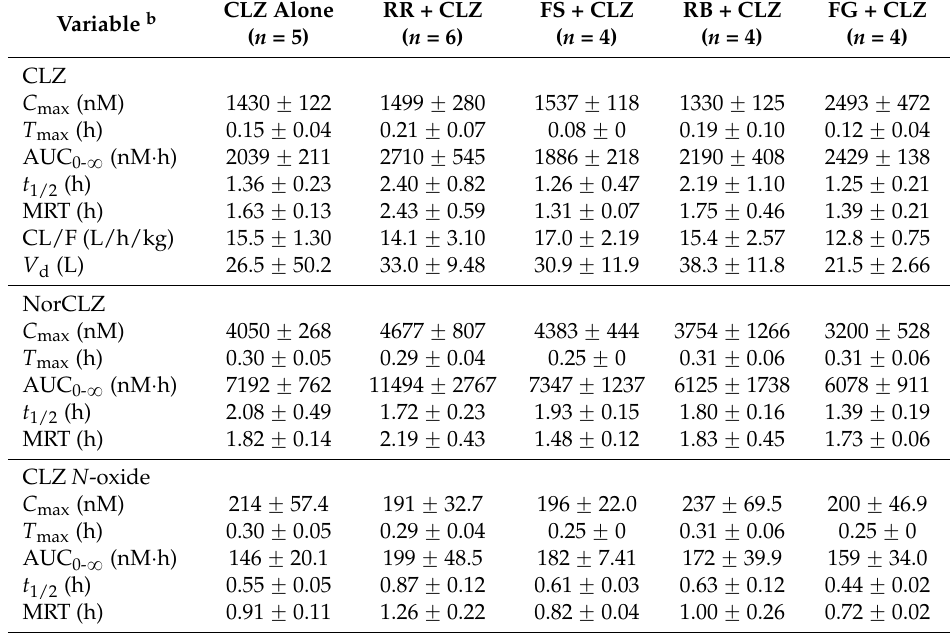
Table 2. Effects of chronic co-treatment with Radix Rehmanniae (RR), Fructus Schisandrae (FS), Radix Bupleuri (RB), and Fructus Gardeniae (FG) on the pharmacokinetics of plasma clozapine, norclozapine (norCLZ), and clozapine N -oxide (CLZ N -oxide) in rats after intraperitoneal administration of 10 mg/kg clozapine for 11 days a,b